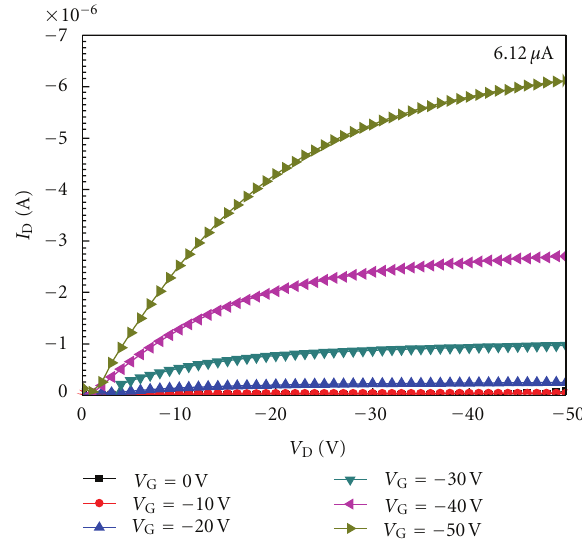
Figure 5: Characteristics of I DS - V DS for pentacene-based TFTs deposited on the PVP-TiO 2 nanocomposite gate dielectric insulator with TiO 2 contents: 3wt% (color line). For the device, the drain voltage ( V DS ) was swept from 0 to − 50 V, and the gate voltage ( V GS ) was fixed at 0, − 10, − 20, − 30, − 40, and − 50 V for each V DS sweep.